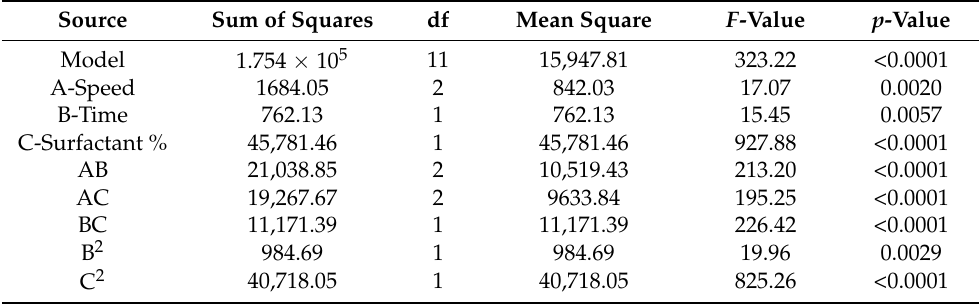
Table 3. ANOVA data for globule size of resveratrol